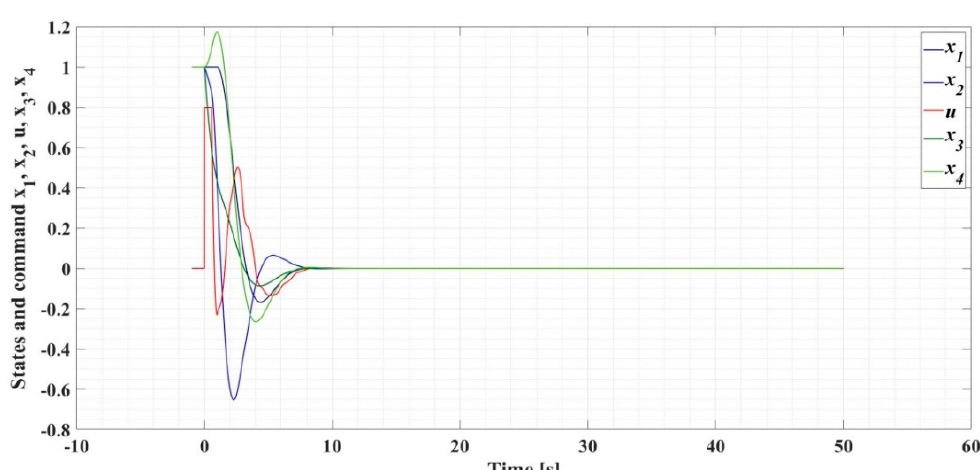
Figure 11. Evolution of the states with ⏐ u ⏐≤ 0.8.